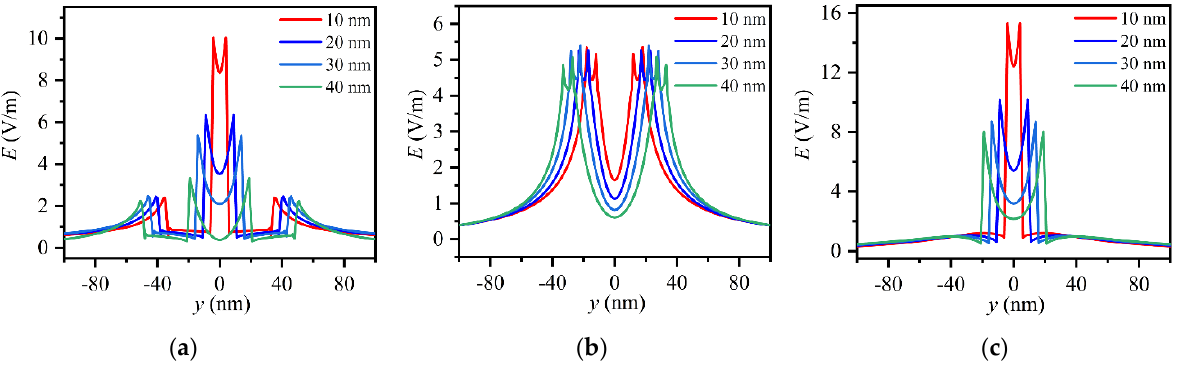
Figure 4. Distributions of electric field along y direction around dual probe with different